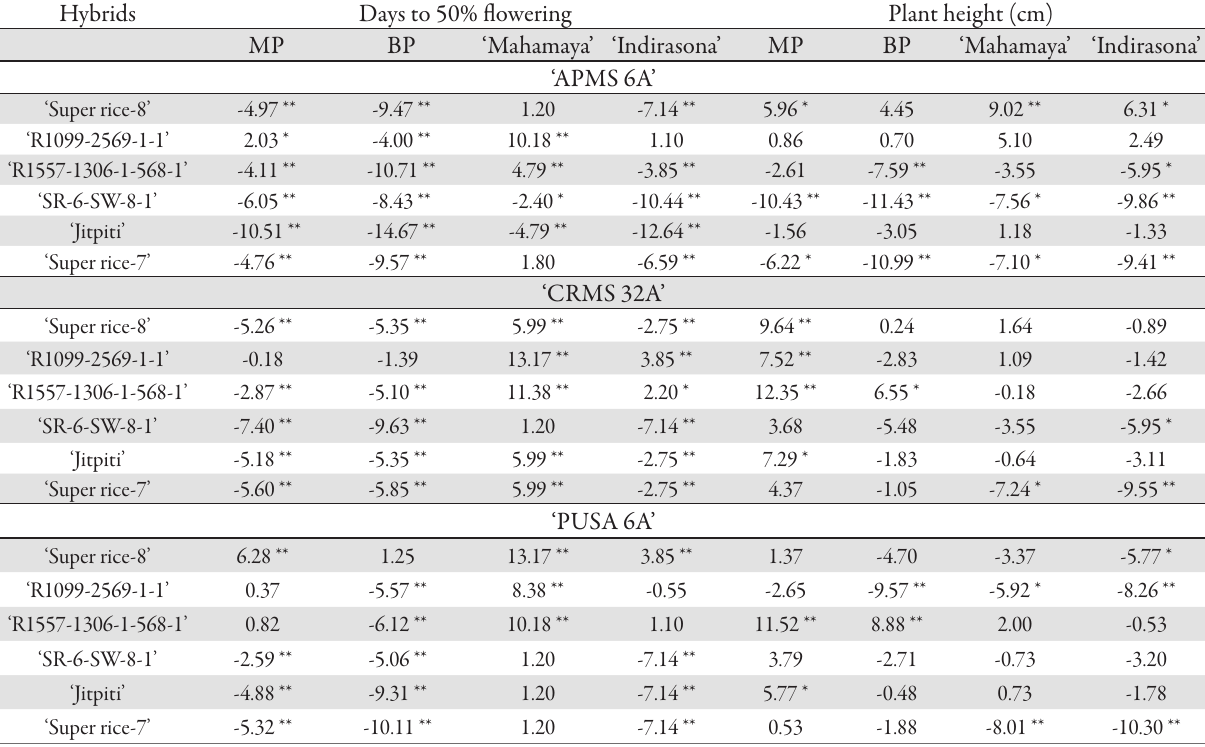
Tab. 3. Percent relative heterosis, heterobeltiosis and standard heterosis for different characters in